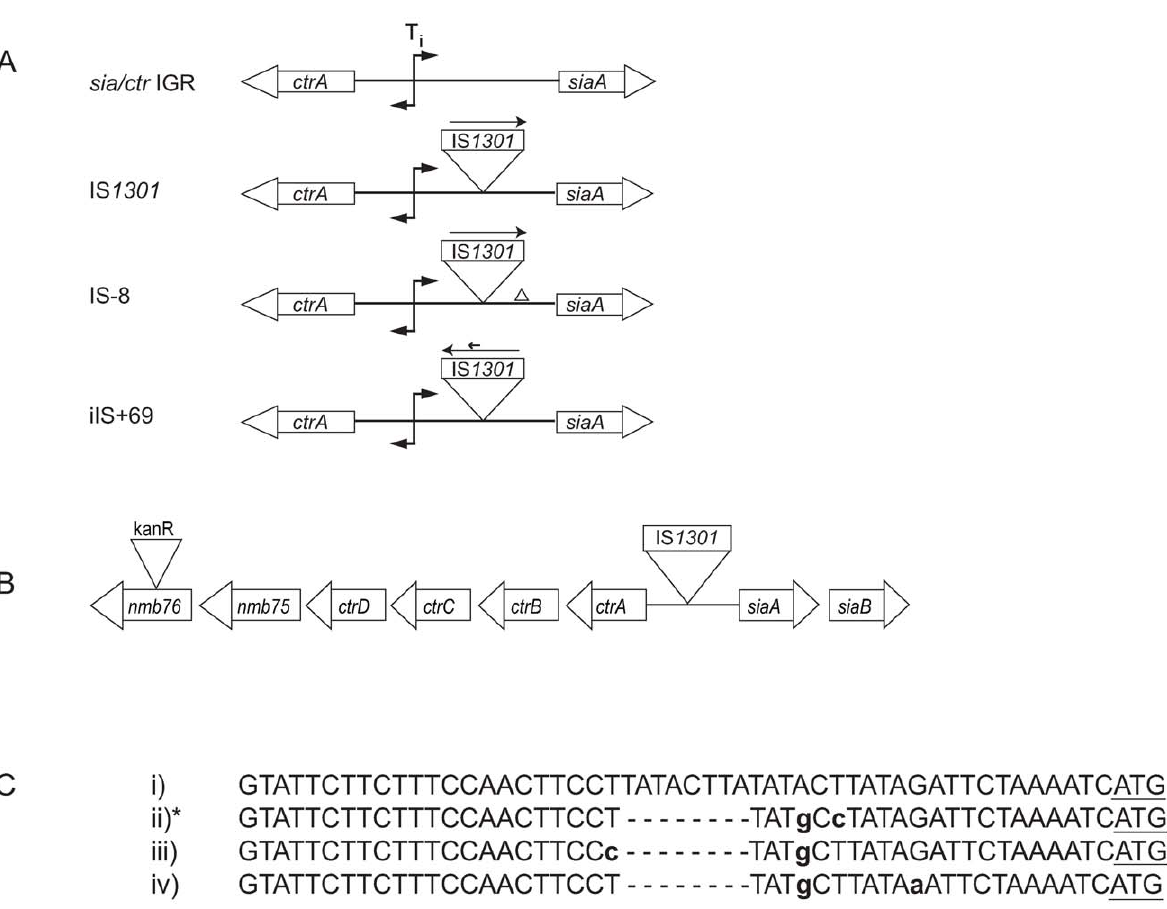
Figure 1. The intergenic region (IGR) between the operons for capsule transport ( ctr ) and biosynthesis ( sia ). A: The transcription initiation site (Ti) is indicated [28] as well as the insertion of IS 1301 in the IGR. The two most common polymorphic IGR with IS 1301 , IS-8 and iIS + 69, are also illustrated. B: Isogenic strains with and without the polymorphisms associated with IS 1301 were constructed by tagging the nmb76 gene downstream of the ctr operon with a kanamycin resistance (kan R ) cassette. C: The 8 bp deletion associated with IS 1301 in the IGR; i) wild-type sequence, and ii) to iv) shows the 8 bp deletion with associated base pair changes (indicated in bold and lower case). * Refers to the most common type of IS-8, which was used for phenotypic analysis. The sequence denotes the base pairs from the insertion site of IS 1301 up to the siaA translational start (underlined).